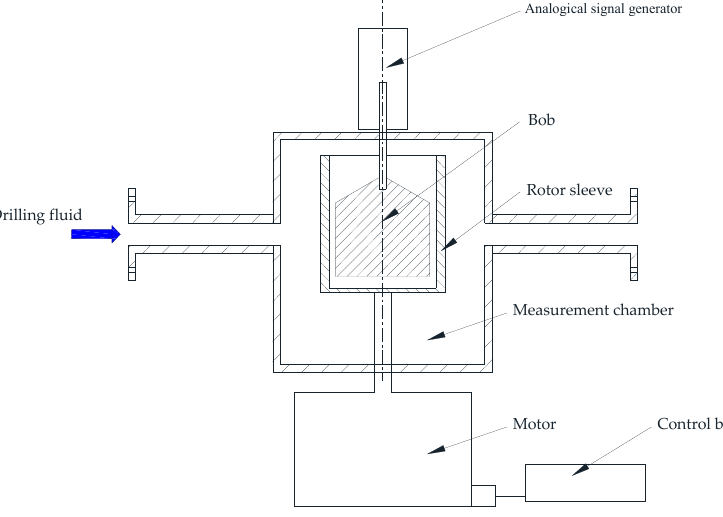
Figure 3. A typical online rotational Couette viscometer schematic diagram. Saasen et al. [21,22] developed an online rotational Couette viscometer. The control box is used to change the rotational speed; shear stress readings were collected and transmuted to the acquisition device. In order to calibrate the drilling fluid’s temperature response over a suitable temperature range, a temperature sensor was attached to the measuring unit. The measurements of the online rotational Couette viscometer were compared to